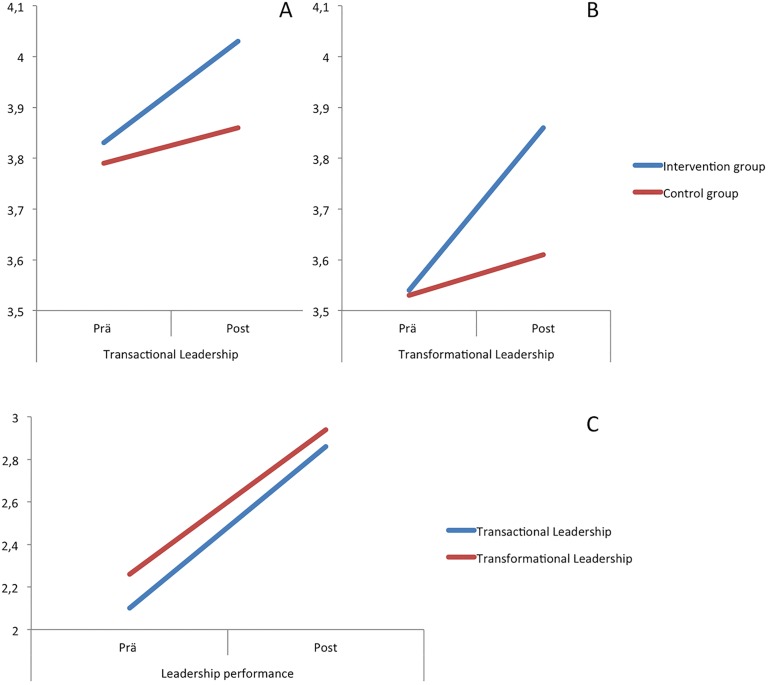
Overview of the effect for the self assessed leadership scale (graph A and B) and the performance scale (graph C).